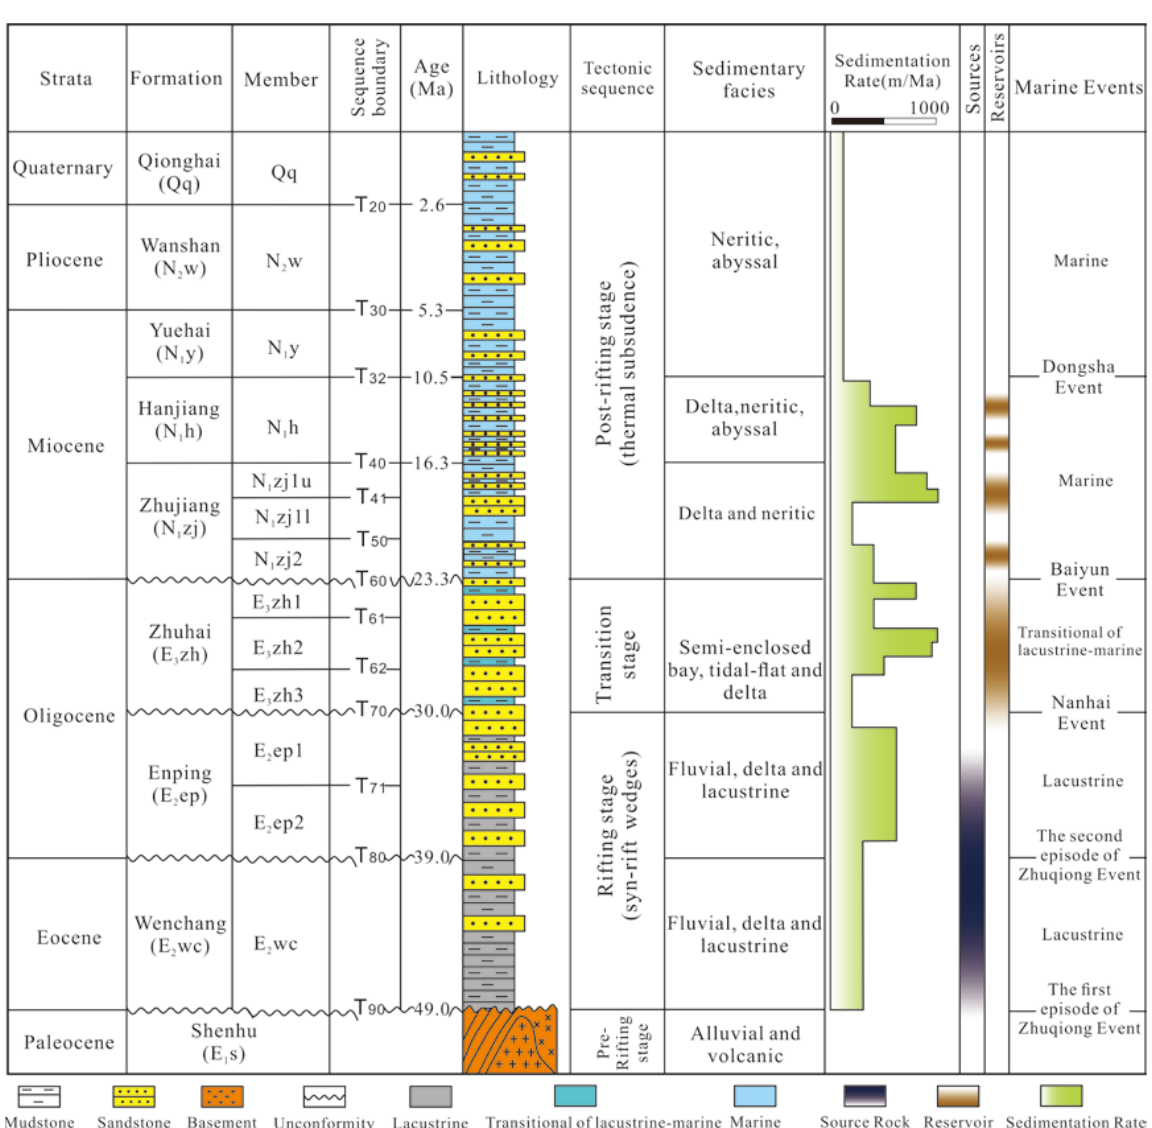
Figure 2. Generalized stratigraphic framework, sedimentary facies, tectonic evolution, and source- reservoir-cap assemblages of the PRMB. The sediment rate curve is from Xie et al. [49].